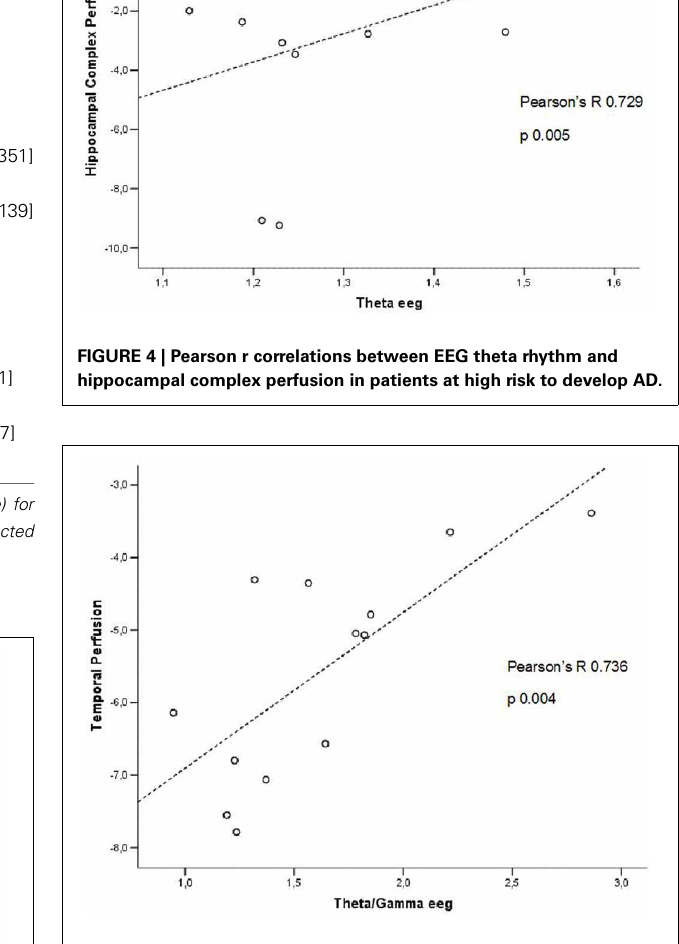
FIGURE 5 | Pearson r correlations between EEG theta/gamma frequency ratio and temporal ROI perfusion in patients at high risk to develop